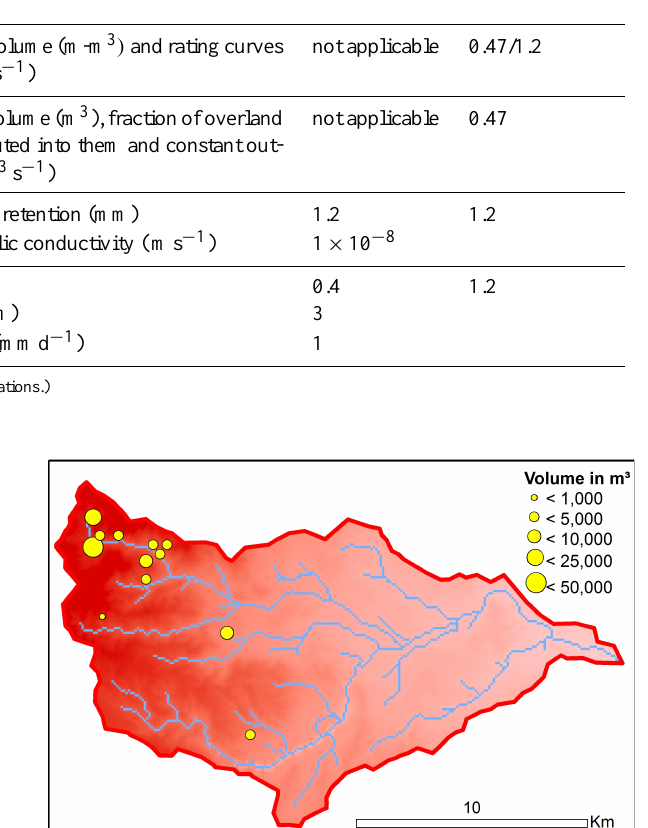
Table 6. Parameters to be considered in the analysis of the retention elements in the landscape scenarios (current storage capacity is null). MODEL/